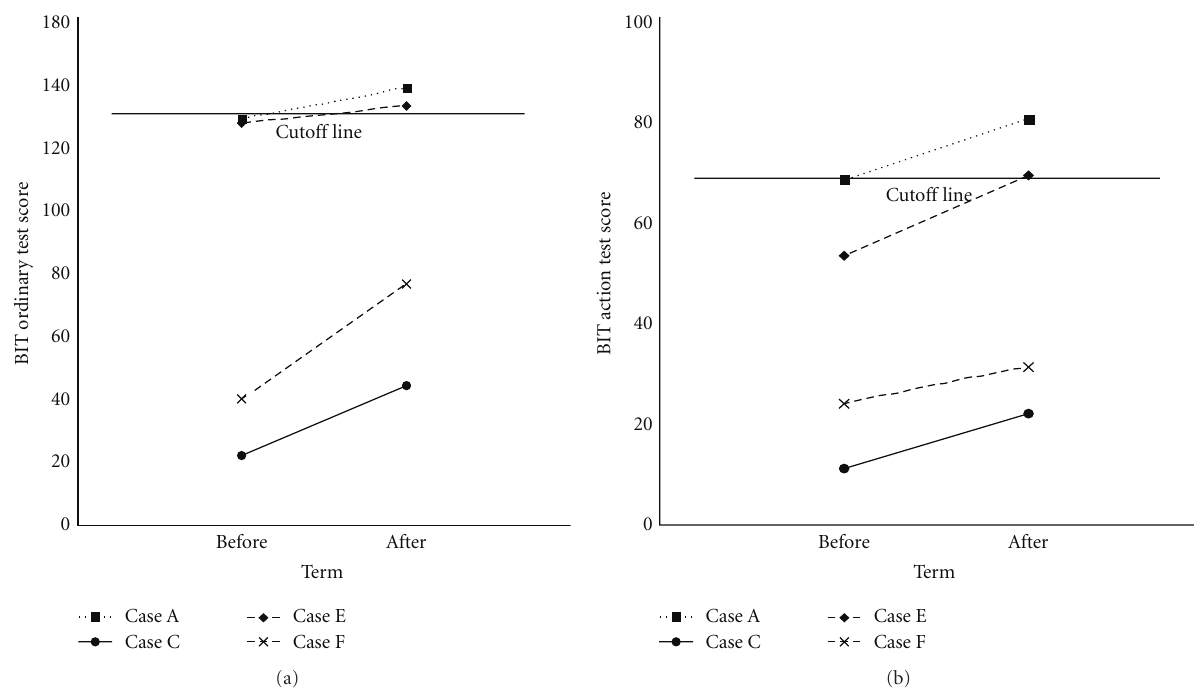
Figure 3: Changes in Behavioural Inattention Test (BIT) scores after the prism adaptation task in the USN(+) group. Cases A and B had higher BIT scores that were over the cuto ff value (131 points for the ordinary test and 68 points for the action test) after prism adaptation. (128 to 138 points and 68 to 80 points for the ordinary and action tests, resp., in case A; 127 to 132 and 53 to 69 correspondingly in case B). USN: unilateral spatial neglect.